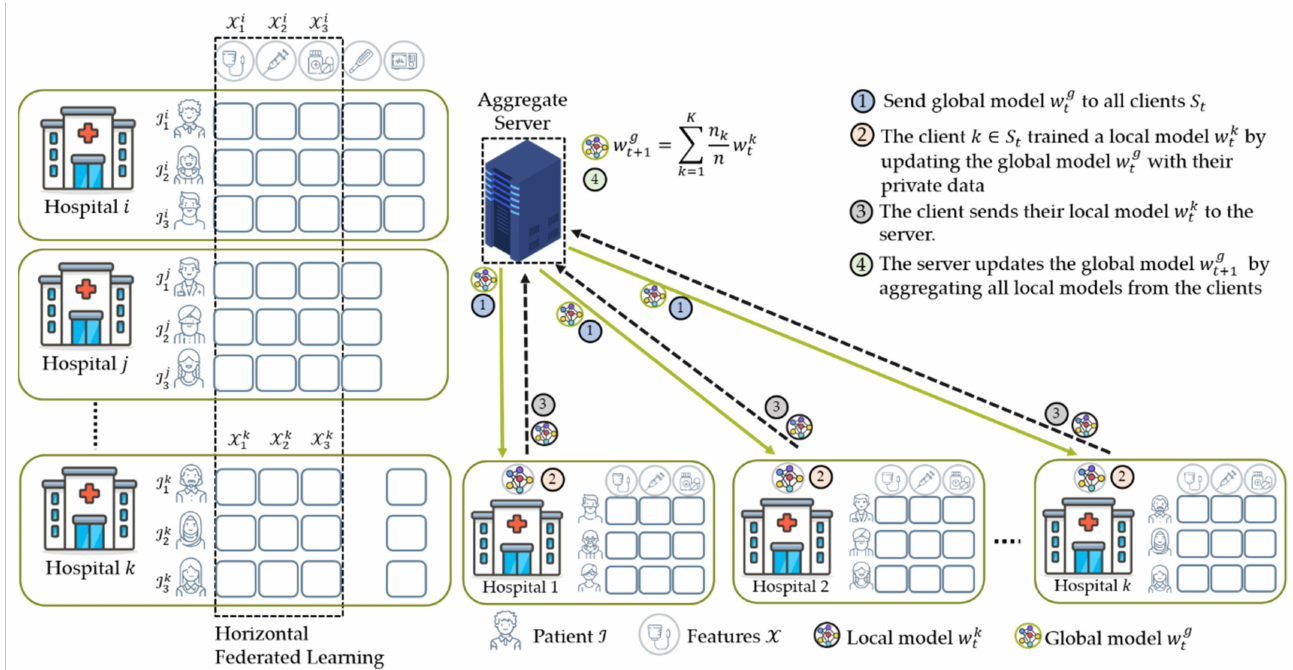
Figure 6. The typical medical data partitions scenario for horizontal federated learning (HFL). Each node is a medical institution data silo or wearable medical device. They share the same feature of medical diagnosis X j = X k but have different patients index I j (cid:54) = I k